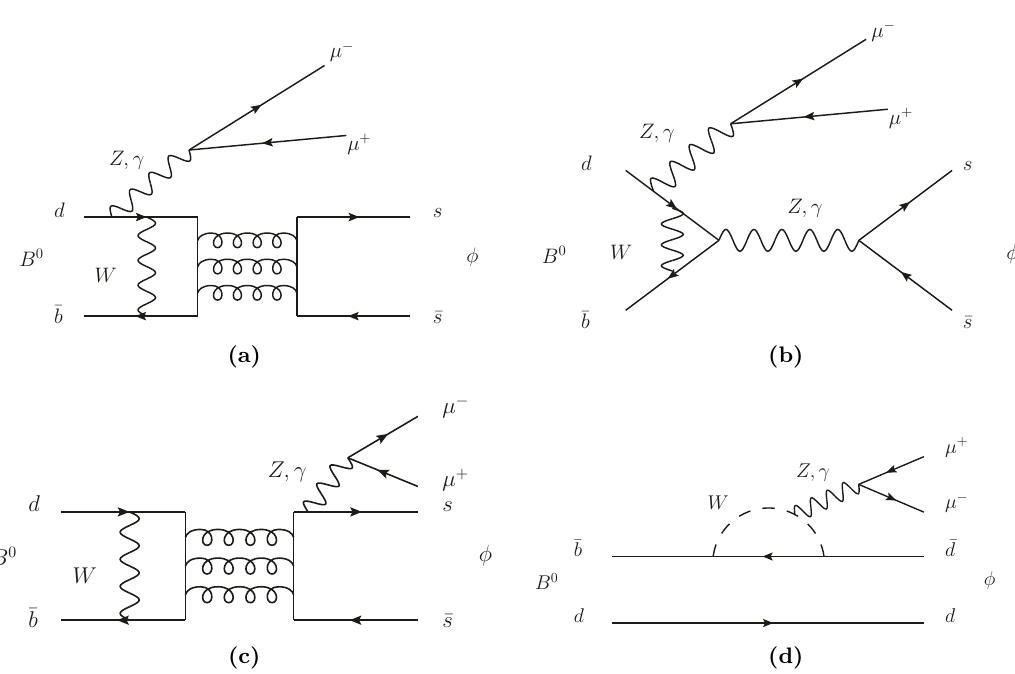
Figure 1. Standard Model Feynman diagrams for the decay B 0 → φµ + µ − . (a), (b), (c) represent the weak annihilation contributions, while (d) represents the contribution from ω − φ